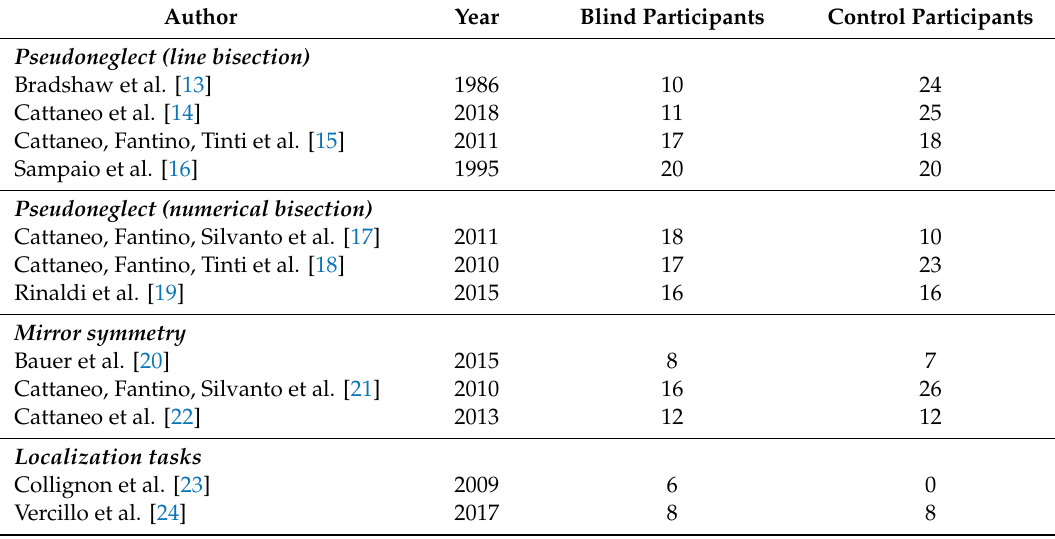
Table 1. The key studies reviewed, divided for the di ff erent spatial laterality tasks (i.e., physical and numerical bisection, mirror symmetry, and localization tasks), along with the number of sighted and blind participants